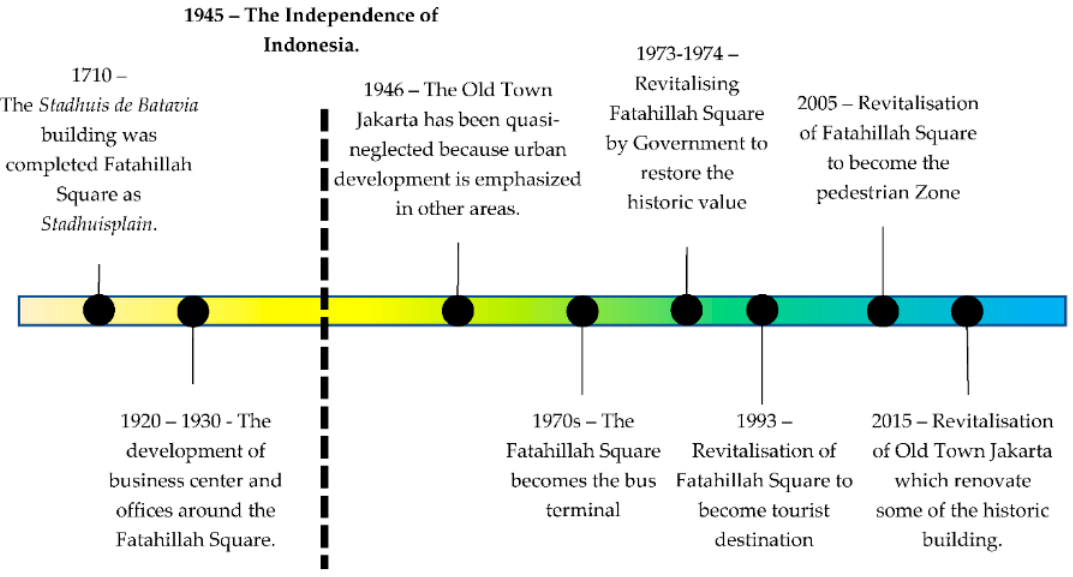
Figure 7. Historical Development Timeline of Fatahillah Square.